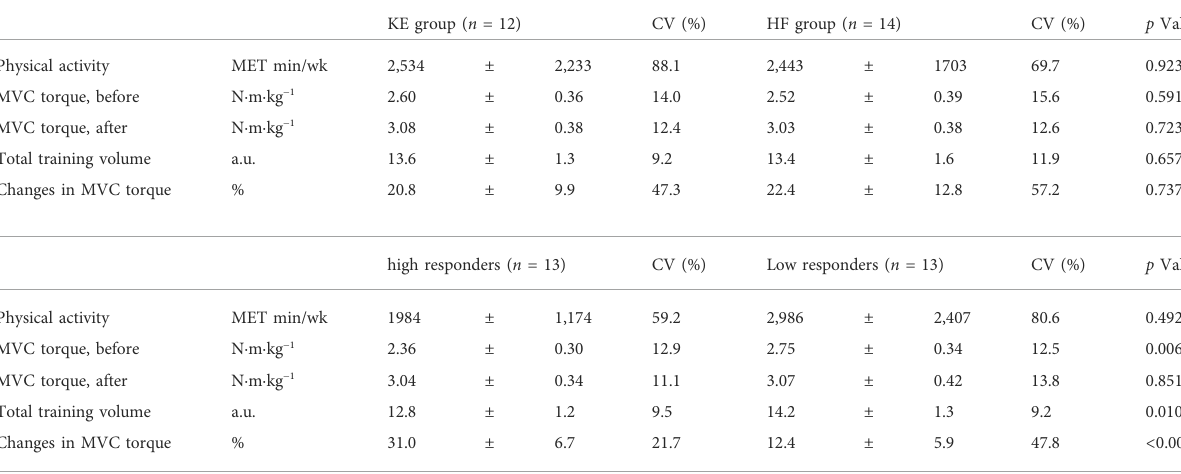
TABLE 1 Dependent variables in each group and in each responder.